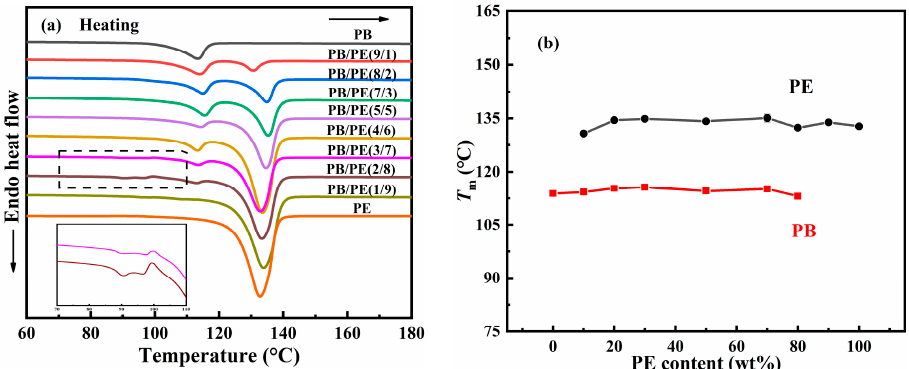
Figure 2. ( a ) DSC heating curves of blends and pure polymers. ( b ) The melting temperatures ( T m ) as a function of PE content.